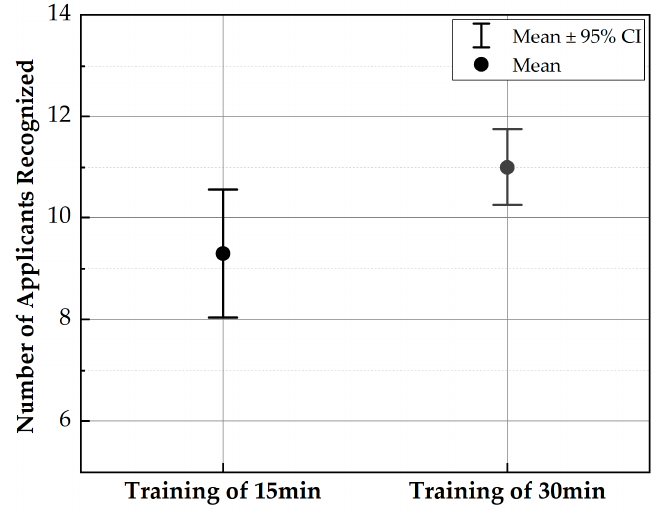
Figure 16. Result of the psychophysical testing with 20 volunteers. Table 4. Psychophysical test survey for the proposed MRTTC.